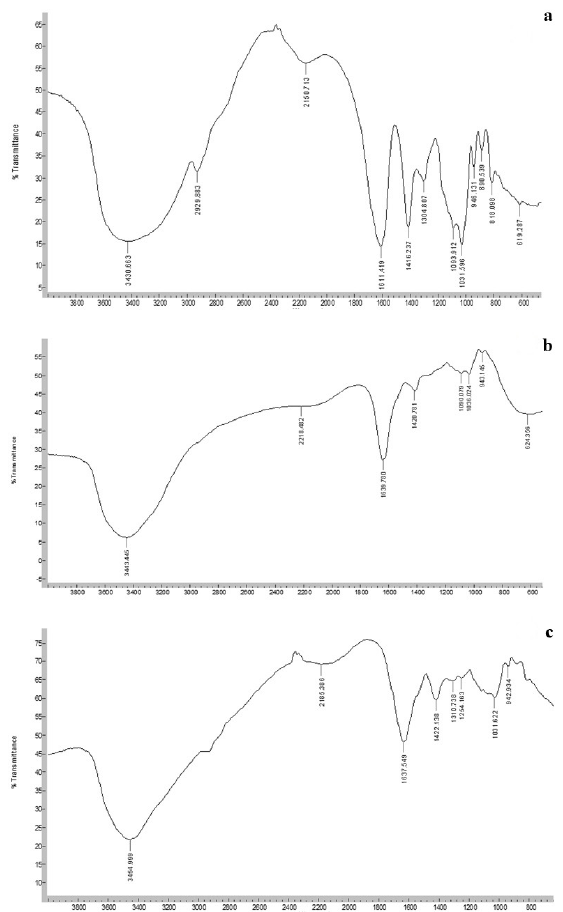
Figure 4 - FTIR spectra of sodium alginate (curve a ), alginate/ gelatin microcapsules humid (curve b ) and dehydrated (curve c